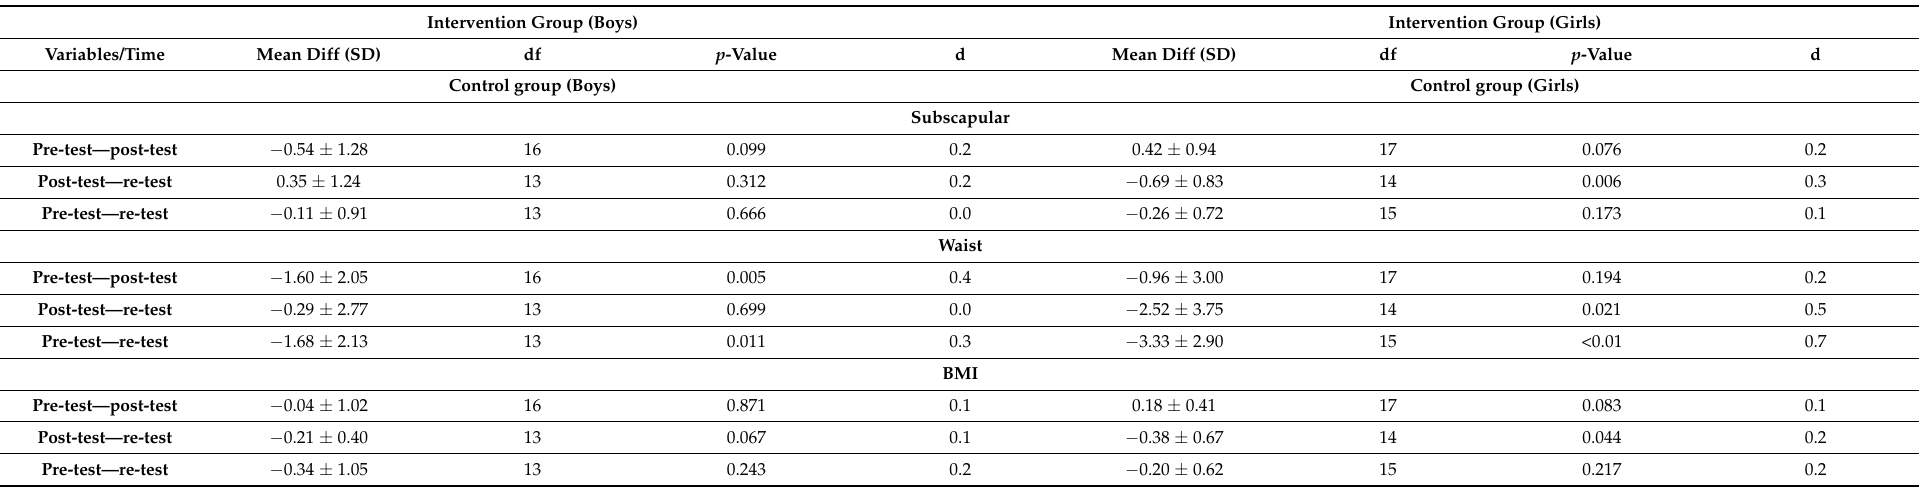
Table 3. Cont. Intervention Group (Boys) Intervention Group